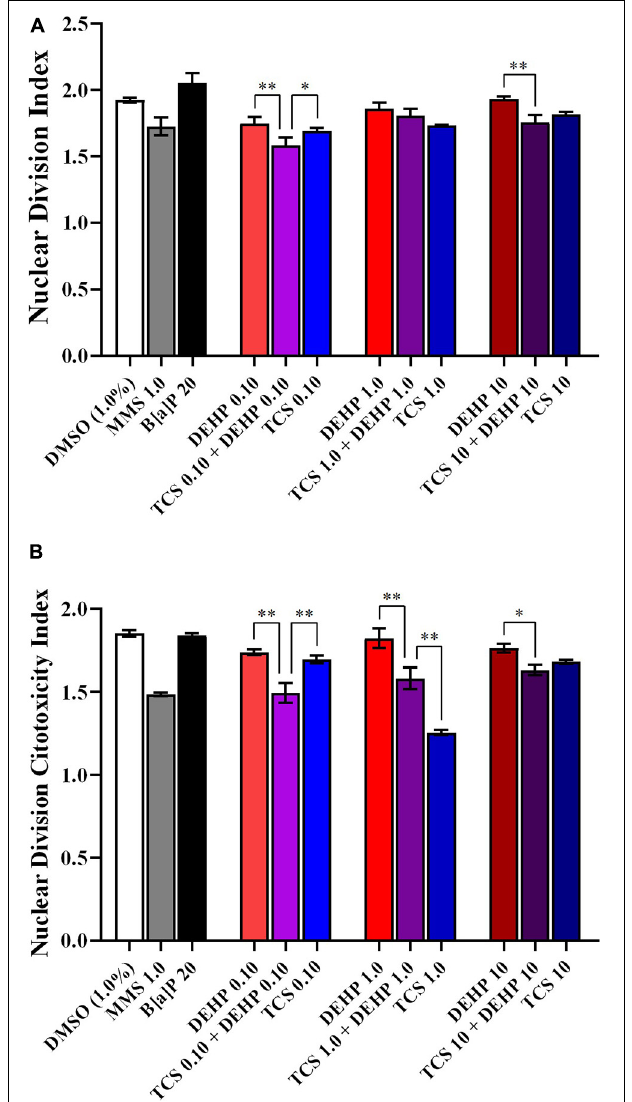
FIGURE 2 | Comparisons between the treatments with TCS + DEHP and their respective groups that receive TCS or DEHP alone, on parameters of cell death: (A) apoptosis and (B) necrosis. All doses are in µ M. ∗∗ p < 0.010; Wald’s chi-square tests followed by Bonferroni correction tests.